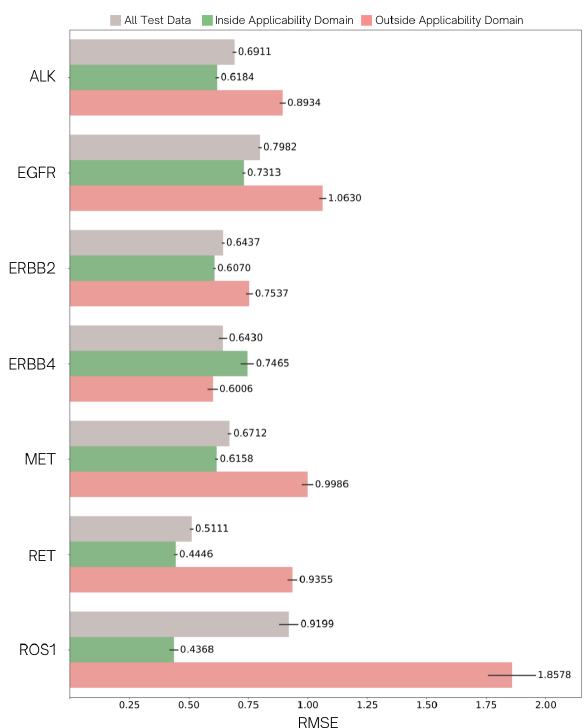
Figure 5. The bar graph presents the influence of the defined applicability domain to external test activity prediction of seven tyrosine kinases in RMSE. Each target consists of three bars, which are denoted for all test datasets (grey), test compounds considered inside (green), and outside (pink) applicability domain. The error bar represents the 95% confidence interval of the variation in predictive performance with 20 different random seeds. The numbers beside each error bar indicate the average RMSE over 20 times of test